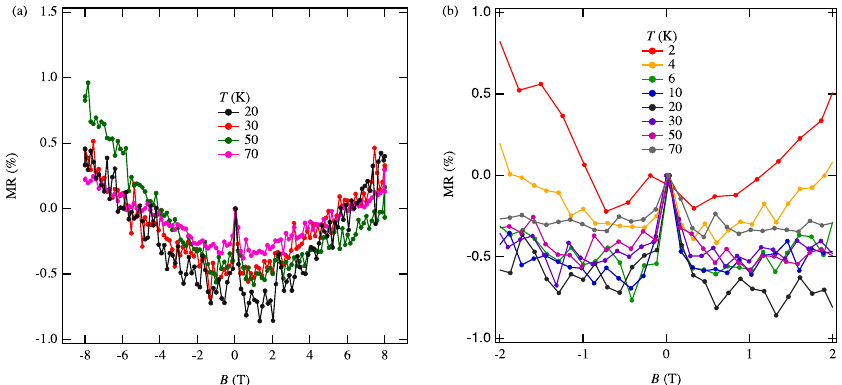
Figure A2. Temperature dependence of MR as a function of magnetic field at 11.8 GPa (sample 8).